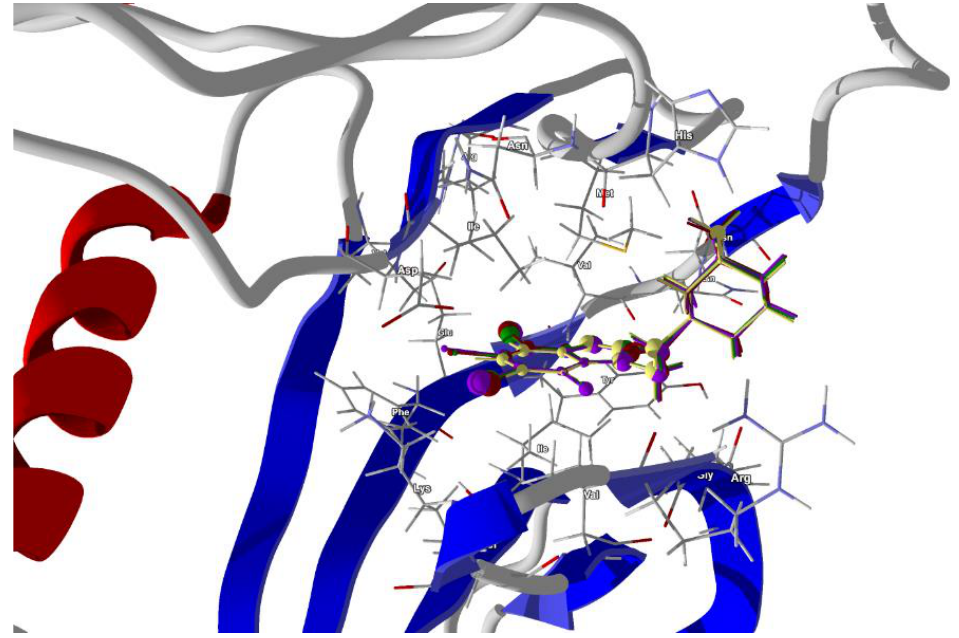
Figure 10. The docked poses of compound AB (yellow), tClAB (green), tBrAB (burgundy) and tIAB (purple) in a binding site of Human Casein Kinase 2, CK2. The protein backbone is represented as a cartoon, the binding cavity residues are shown as sticks and docked ligands are shown as a ball and a stick (the size of the ball is proportional to the strength of the interactions). Table 10. Docking and scoring results obtained for the compounds studied.